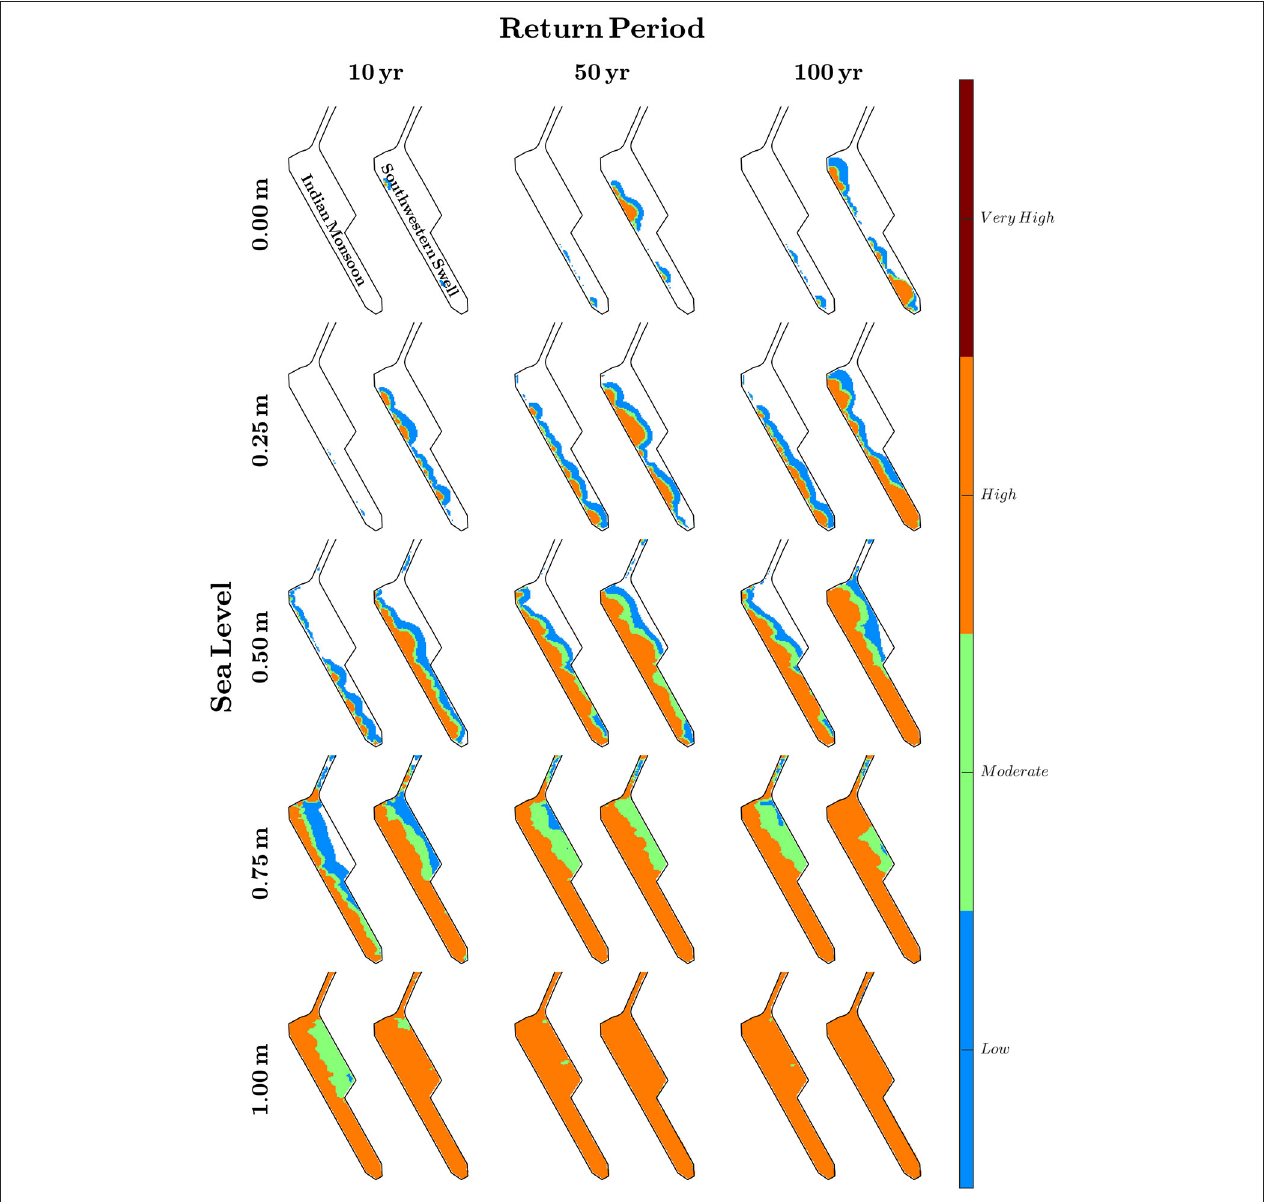
FIGURE 10 | Level of hazard on the new airport for all the SWASH simulations. The colourscale indicates the level of hazard defined by a combination of water height on the airport and water velocity (see Supplementary Figure 16 ). Different sea levels are represented at each row while the columns indicate return periods of H s (10, 50, and 100 years) as defined in the text for the regional wave climate. For each combination of sea level and return period, the result for the Indian Monsoon and Southwestern swell are shown at left and right,